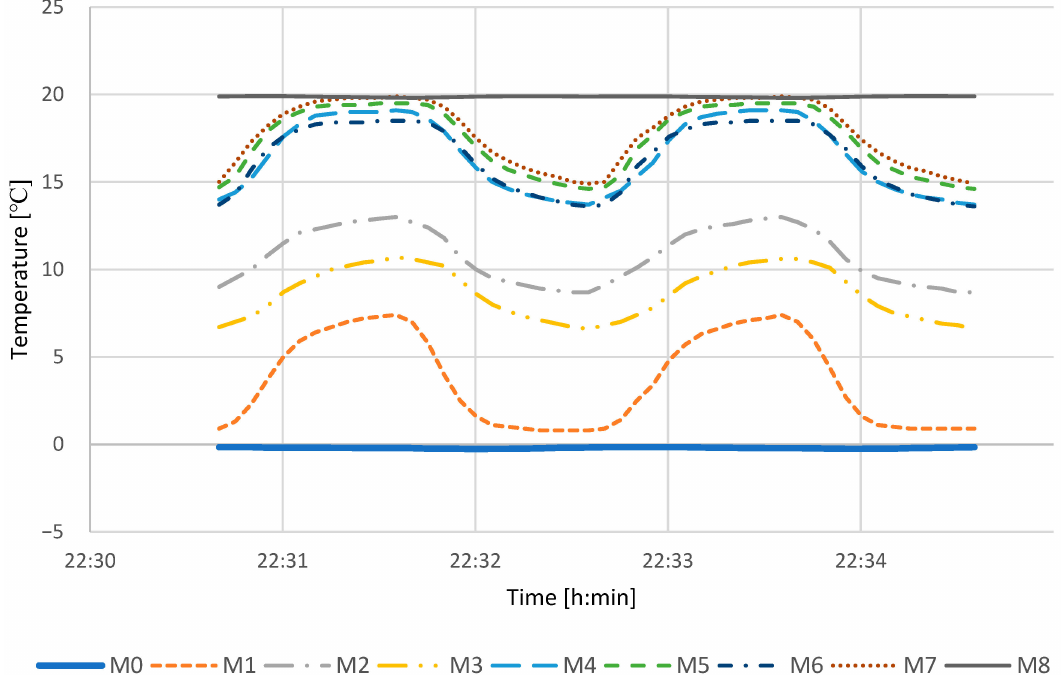
Figure 14. Change in temperature in measuring points marked M0–M8, when the first heat exchanger, filled with jojoba oil, was used. The external temperature equals 0 ◦ C and internal temperature equals 20 ◦ C. The supply and exhaust cycles were 1